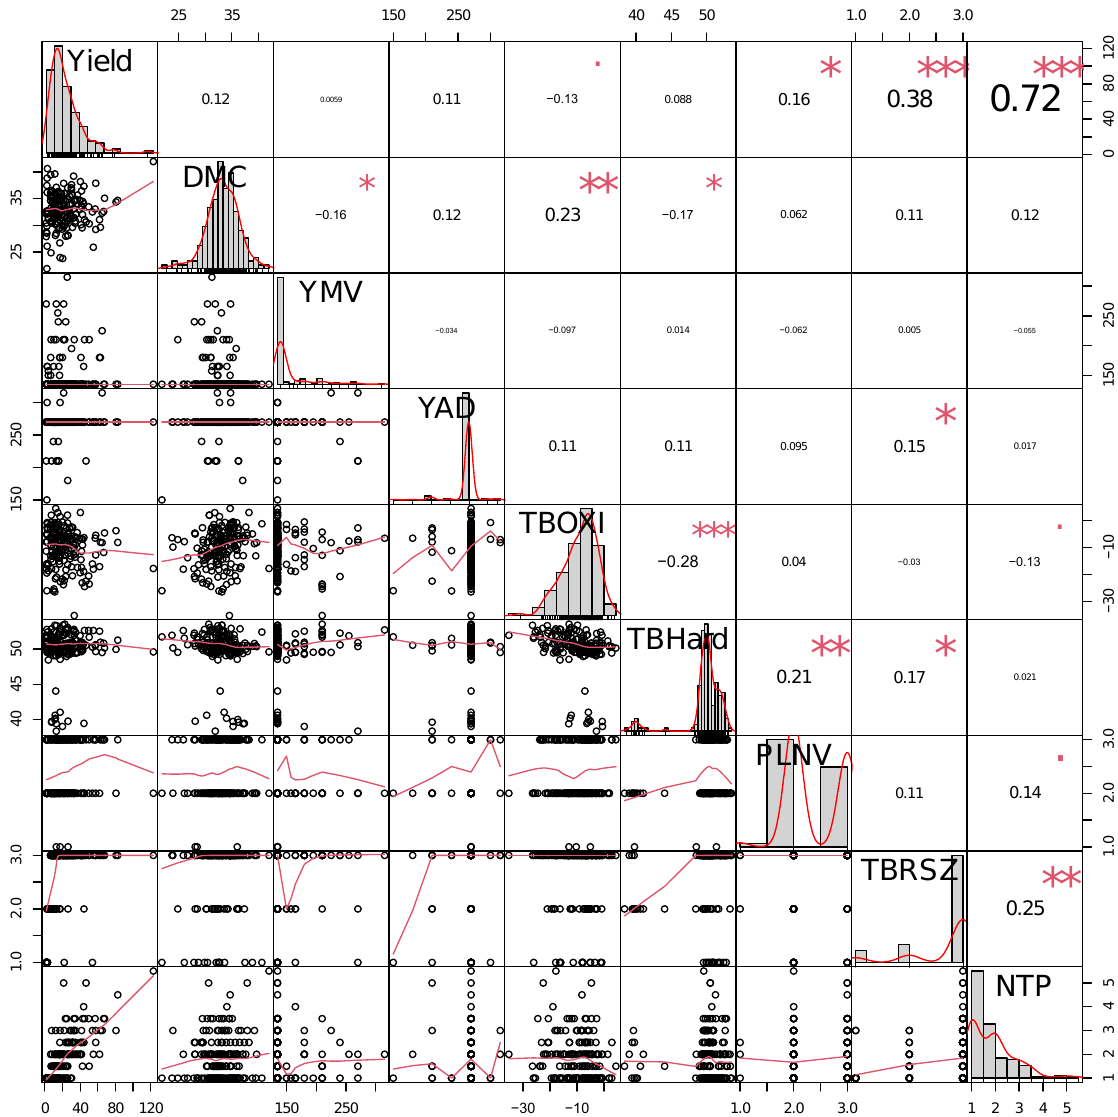
Hierarchical clustering based on agronomic and quality trait performance grouped the genotypes of D. praehensilis and D. rotundata into three groups (Figure 3). Cluster 3 had the highest number of genotypes (79), while cluster 1 had the lowest number (39). Hierarchical clustering revealed high significant variation in the distribution of D. praehensilis and D. rotundata genotypes among the clusters (Table 5). Cluster 1 comprised of genotypes of D. praehensilis and D. rotundata that possessed low tuber yield (12.19 t ha − 1 ), high dry matter content (33.14%), high susceptible to YMV, high YAD resistance, moder- ate tuber flesh oxidation, minimal tuber flesh hardness and moderate plant vigour, low number of tubers per plot, and small tuber size (Table 5; Figure 3). Among members of cluster 1, we had: Puna, Nyaminti, Puna_Central, Olodo-1, Asana, Dente, Alata_Puna, Nyamint, Durben, Mutwu, and CDpr54 as the genotypes with low tuber flesh hardness; and CDpr50, WNDpr50, WNDpr74, Dente, Puna, WNDpr4, Olodo, WNDpr10,